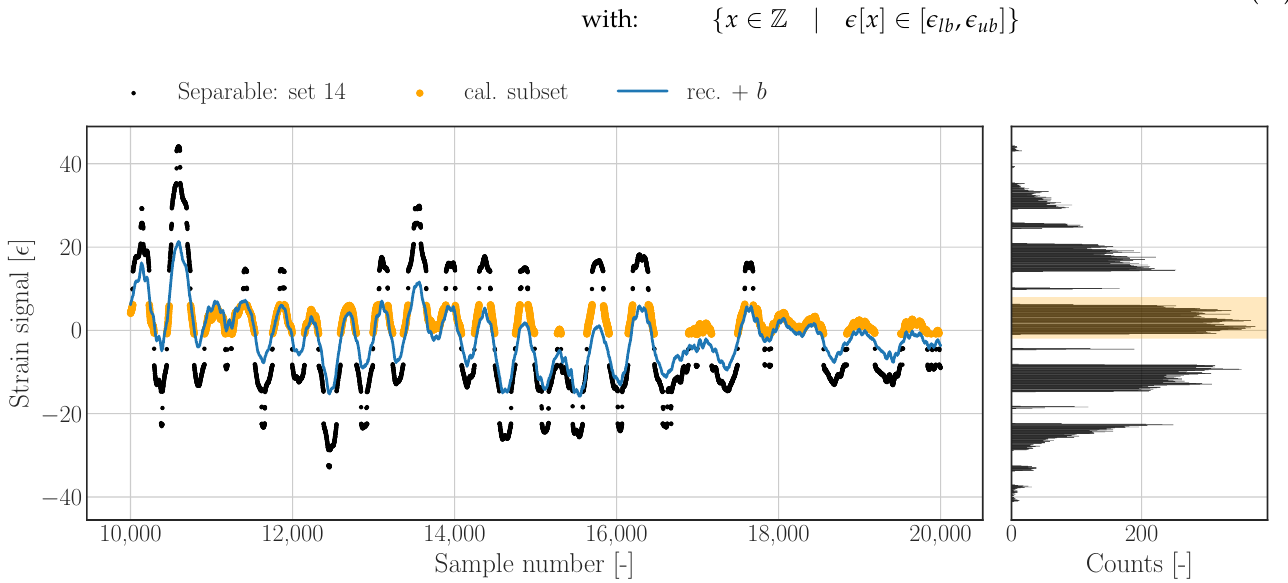
Figure 7. Raw (union of black and orange) and reconstructed time series (blue) with calibrated mean value based on optimizing the overlap of the reconstruction with a calibration subset